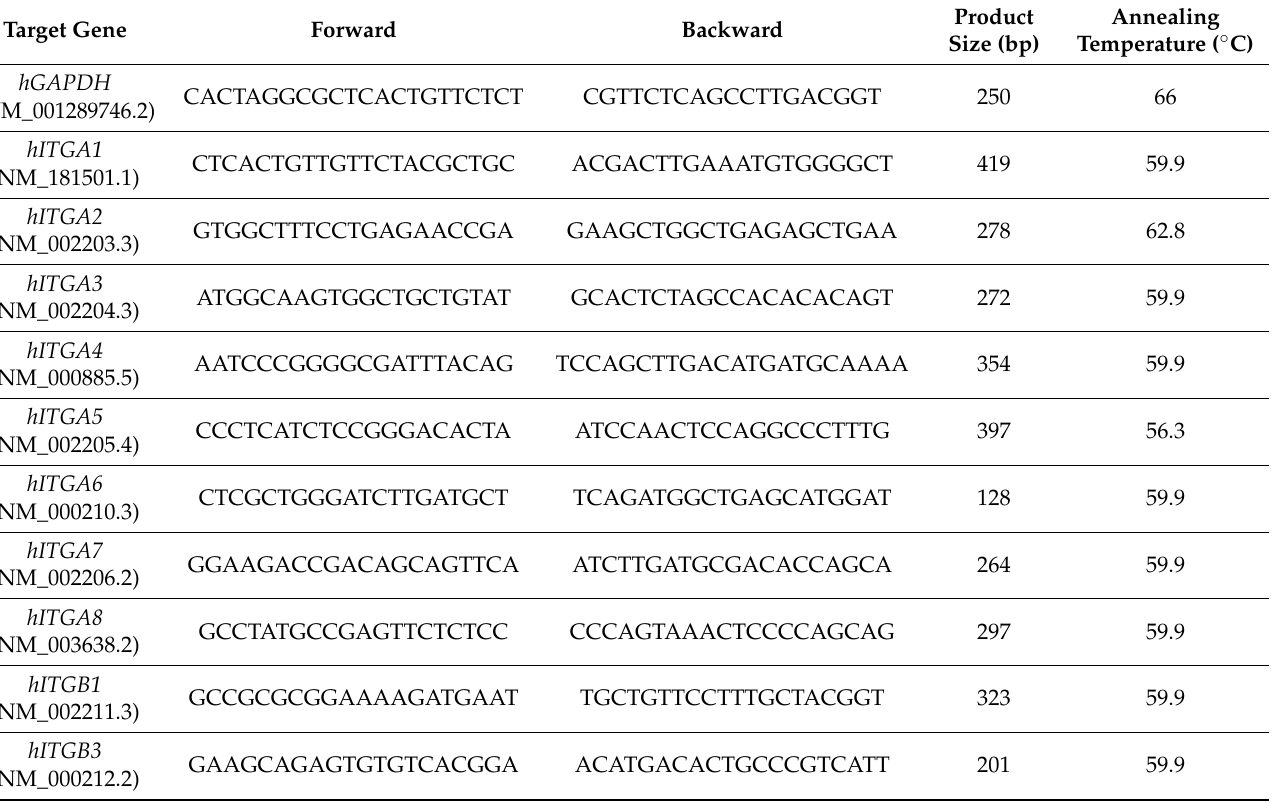
Table 2. Human primer information for real time